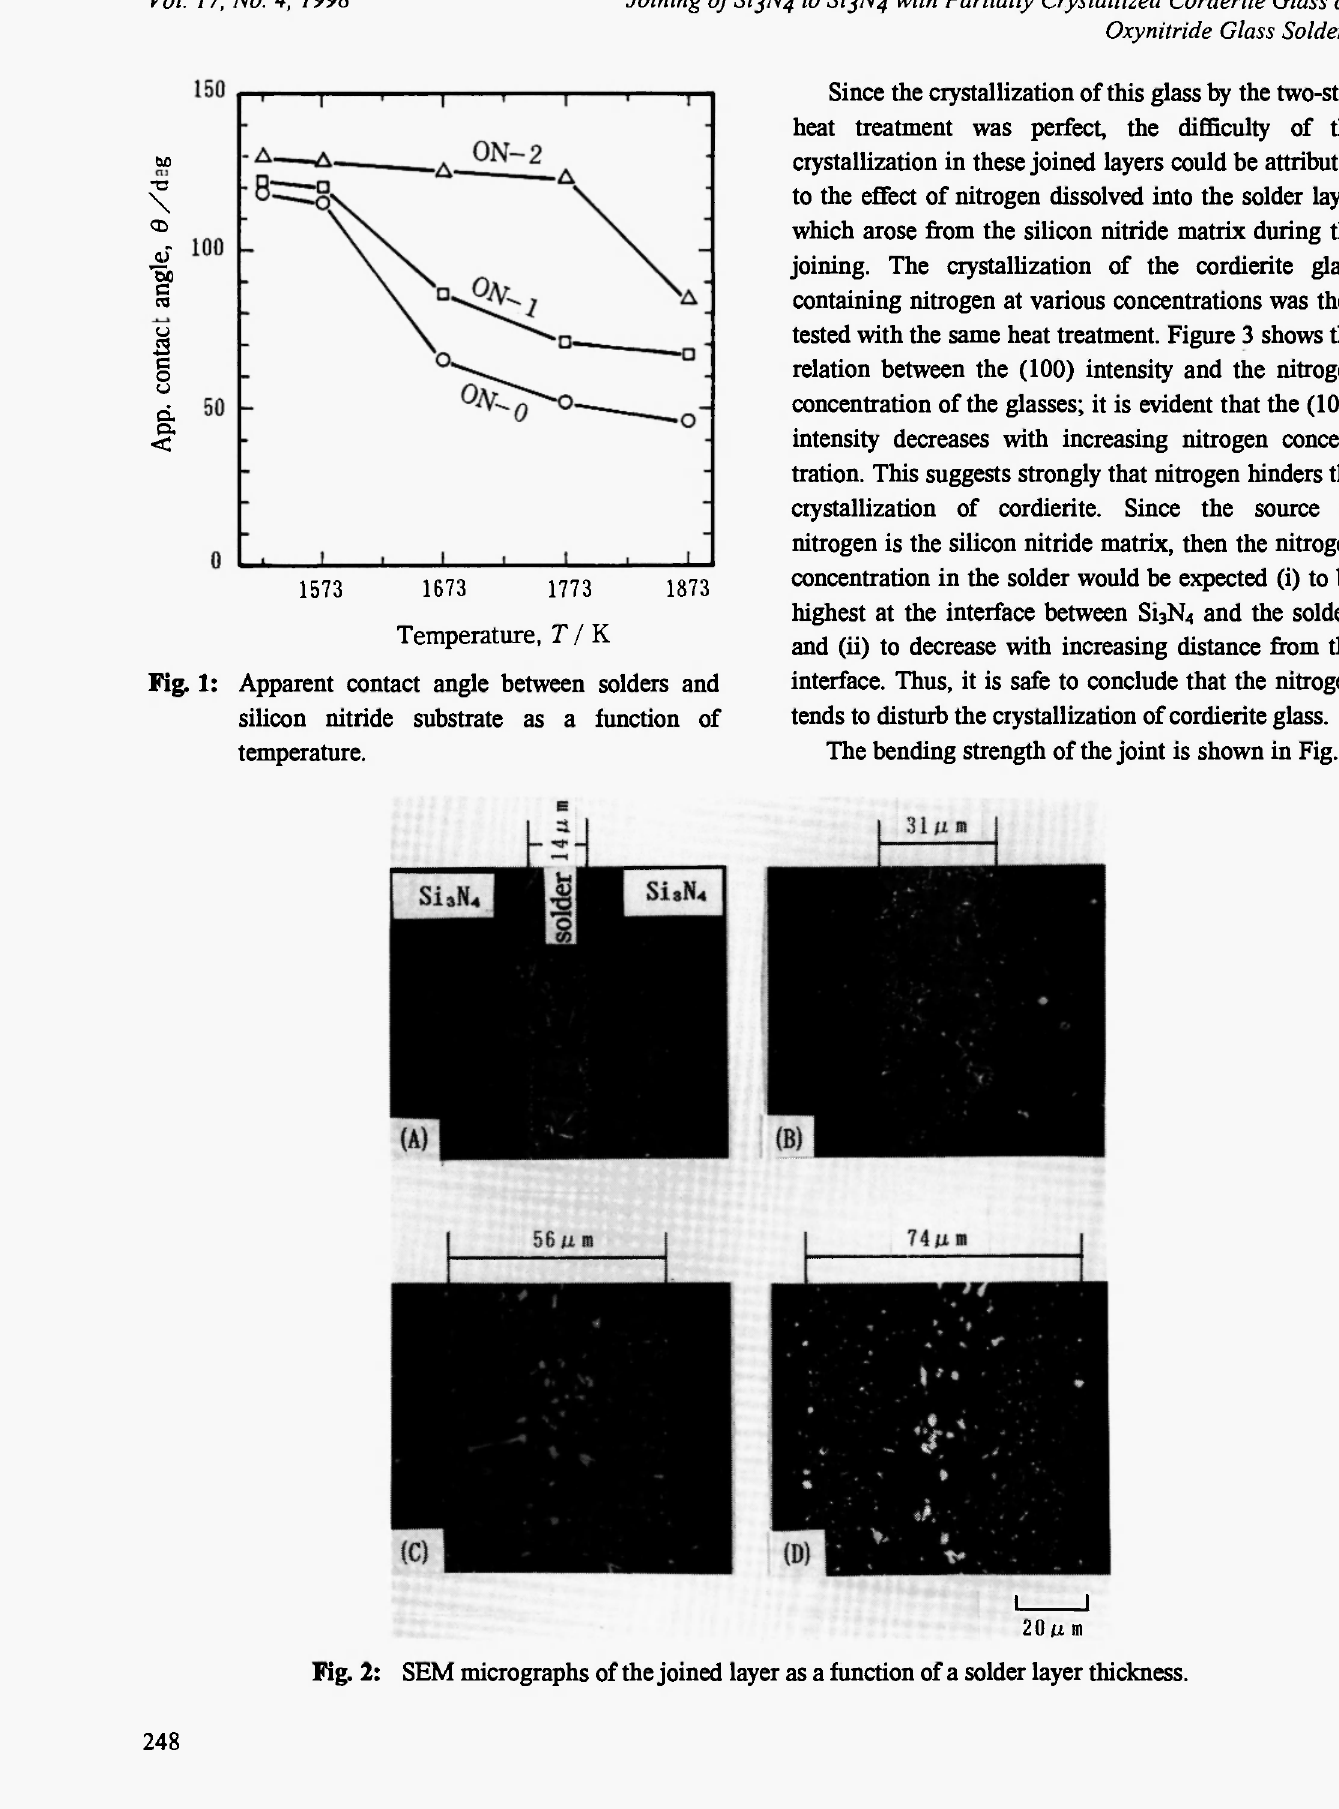
Fig. 1: Apparent contact angle between solders and silicon nitride substrate as a function of temperature.